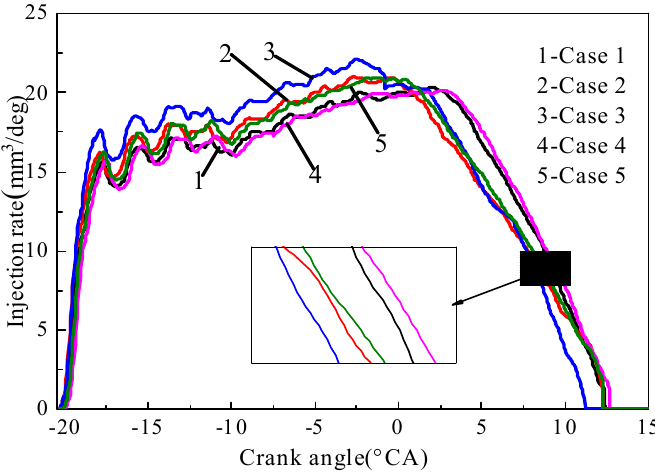
Figure 6. Fuel injection rate with ca onstant fuel injection mass.